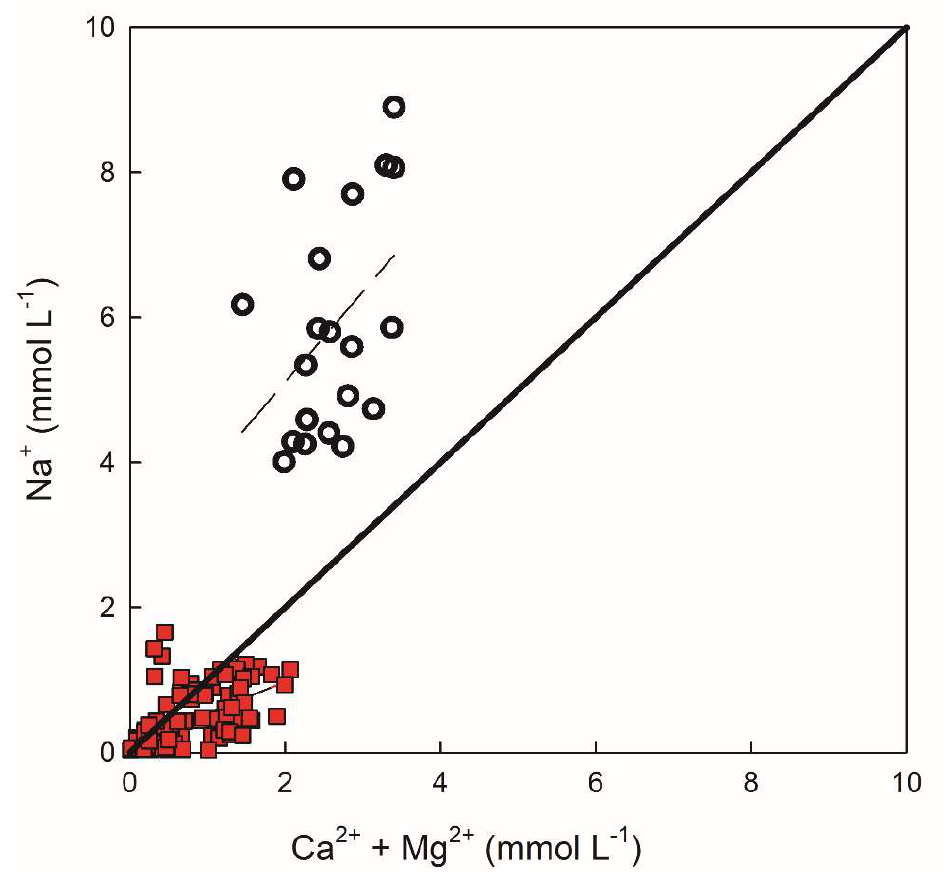
Figure 3. Relationship between Na + and divalent cations (Ca 2+ + Mg 2+ ) for natural rich fens in Alberta (red squares, r 2 = 0.347) and brackish wetlands (black circles, r 2 = 0.187). Thick line is a 1:1 concentration of cations in mmol L −1 .